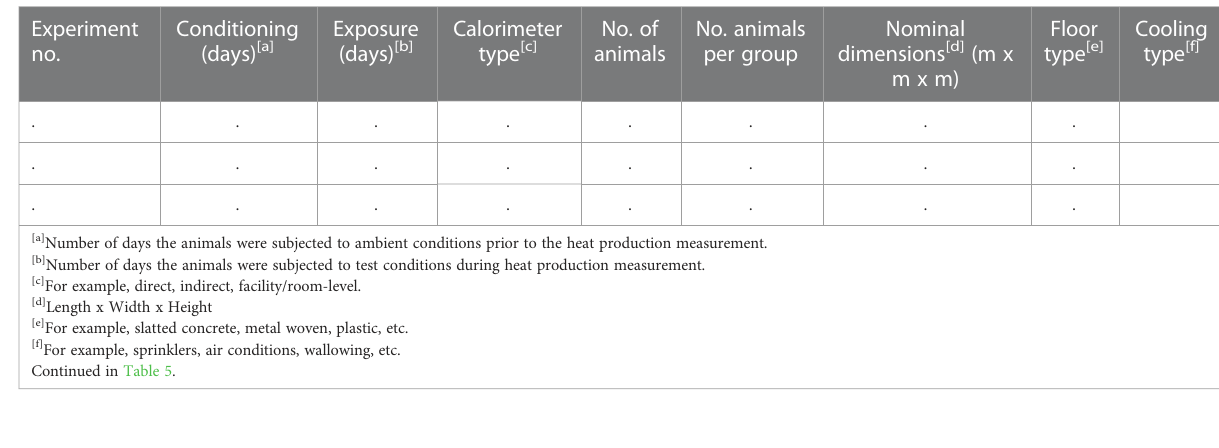
TABLE 5 Continuation of Table 4 of proposed standard reporting of heat production data. Experiment no.